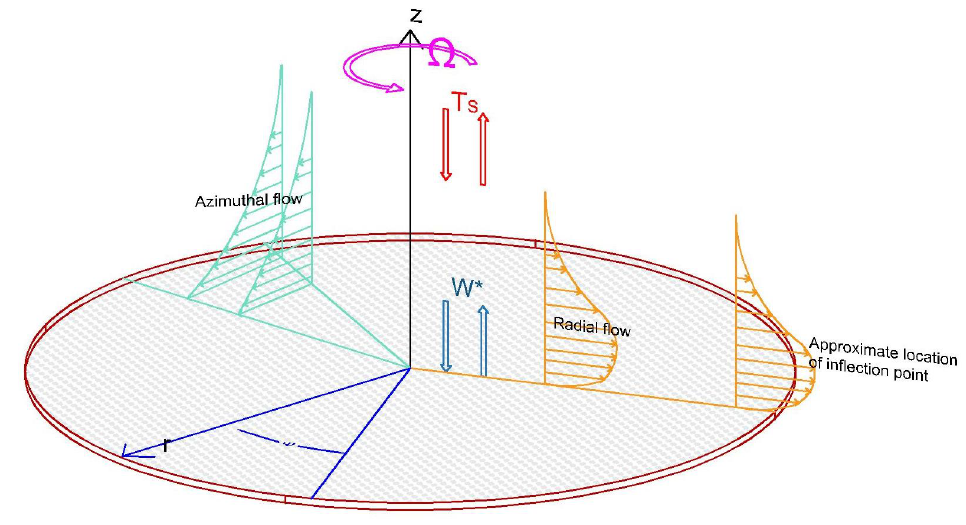
Figure 1. Rotating disk diagram is showing model setup in axial flow within suction and